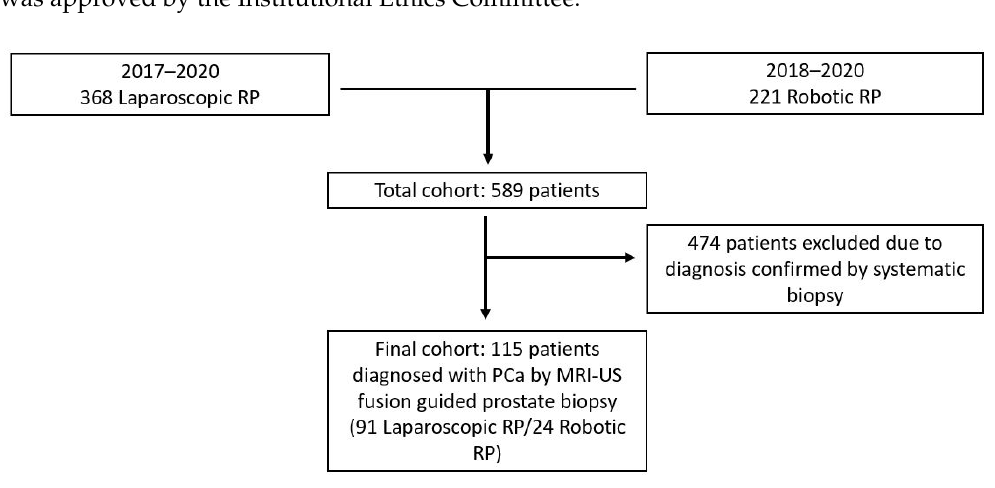
Figure 1. Flow diagram illustrating cohort selection for the current study.